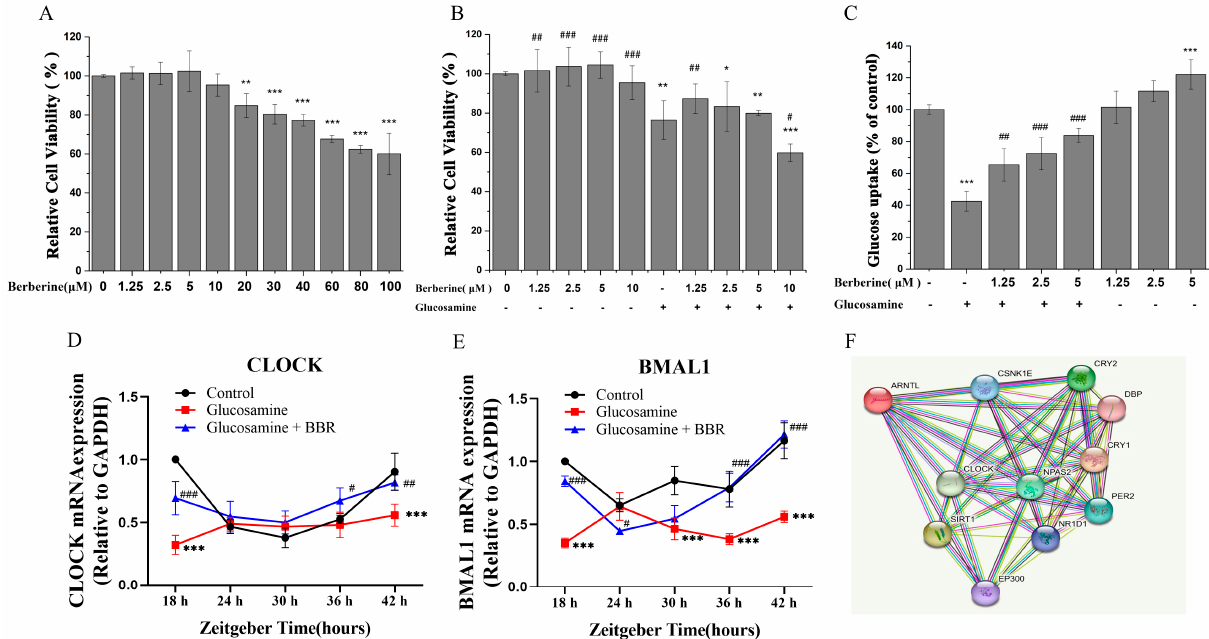
Figure 3. BBR alleviated glucosamine-impaired glucose uptake and increased mRNA of Clock and Bmal1 in HepG2 cells. ( A ) Relative viability of HepG2 cells treated with different concentrations of BBR measured by CCK-8 assay; ( B ) relative cell viability treated with BBR (1.25, 2.5, 5.0, and 10.0 µ M) and co-treated with/without 20 mM glucosamine; ( C ) glucose uptake in groups treated with BBR (1.25, 2.5, and 5.0 µ M) and co-treated with/without glucosamine (20 mM); ( D ) mRNA expression of Clock; ( E ) mRNA expression of Bmal1; ( F ) protein-to-protein interaction of Clock and Bmal1. Data are presented as the mean value ± SE ( n ≥ 6): * p < 0.05, ** p < 0.01, and *** p < 0.001 compared to the control group. # p < 0.05, ## p < 0.01, and ### p < 0.001 compared to the glucosamine group. After the co-treatment with the glucosamine (20 mM) and BBR (1.25, 2.5, 5, and 10